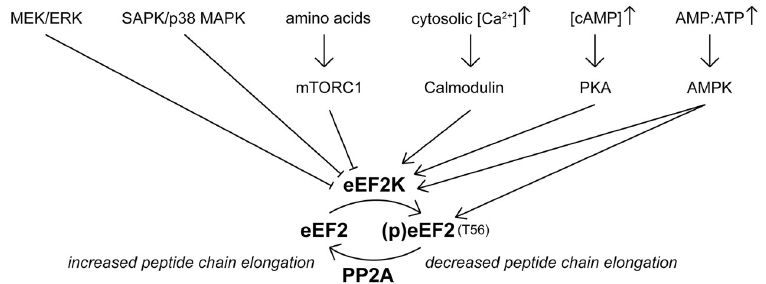
Fig 6. Regulation of eEF2 phosphorylation. Schematic overview of different pathways involved in regulating eEF2 phosphorylation. An increase in the cytosolic Ca 2+ concentration activates eEF2K. Activation of PKA by an increased concentration of cAMP activates eEF2K. Activation of AMPK by an increase in the AMP:ATP ratio activates eEF2K and AMPK possibly also directly phosphorylates eEF2. eEF2K can be inhibited by mTORC1, the MEK/ERK pathway and SAPK/p38 MAP kinases. eEF2 T56 phosphorylation is reversible through dephosphorylation by PP2A.